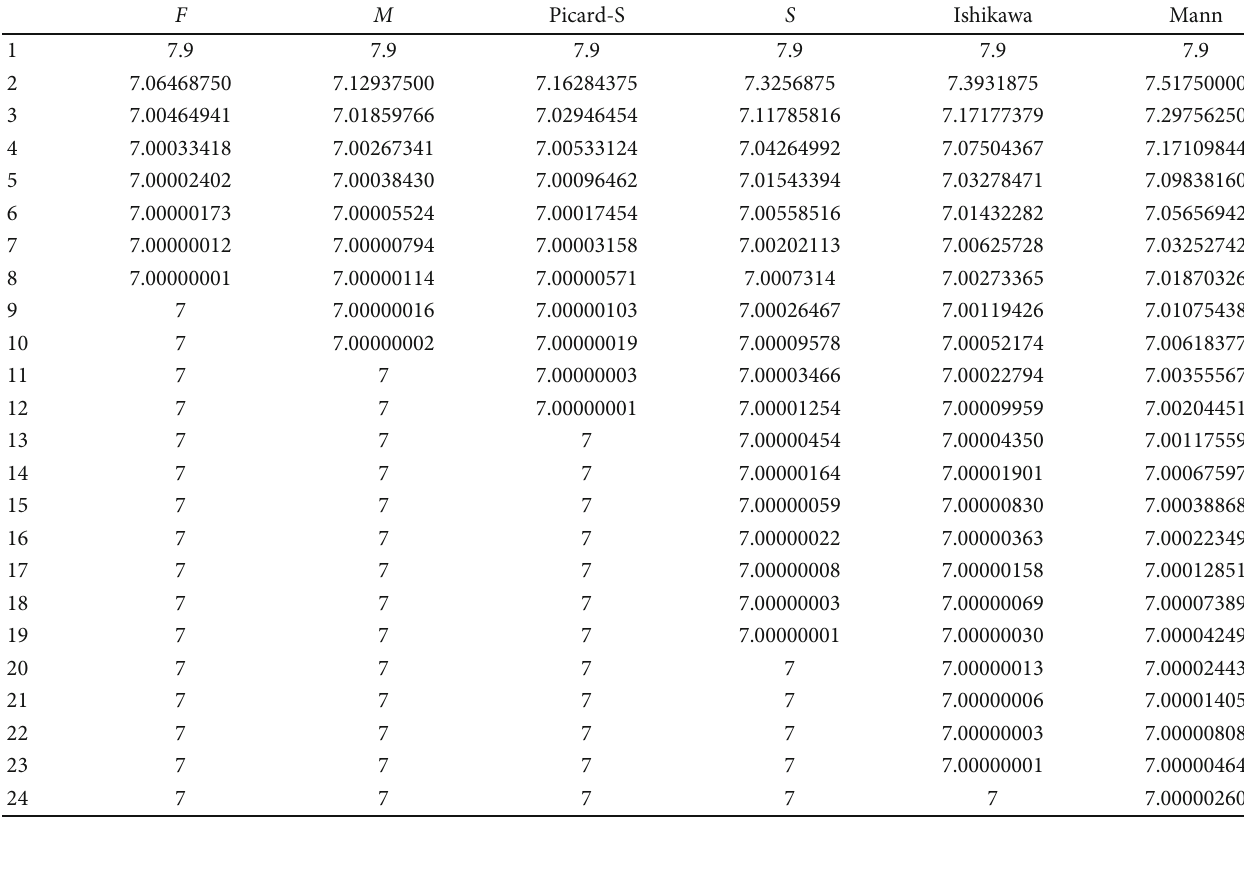
Table 1: Numerical data generated by F , M , Picard-S, S , Ishikawa, and Mann iterative approximation schemes for the self map given in Example 12.